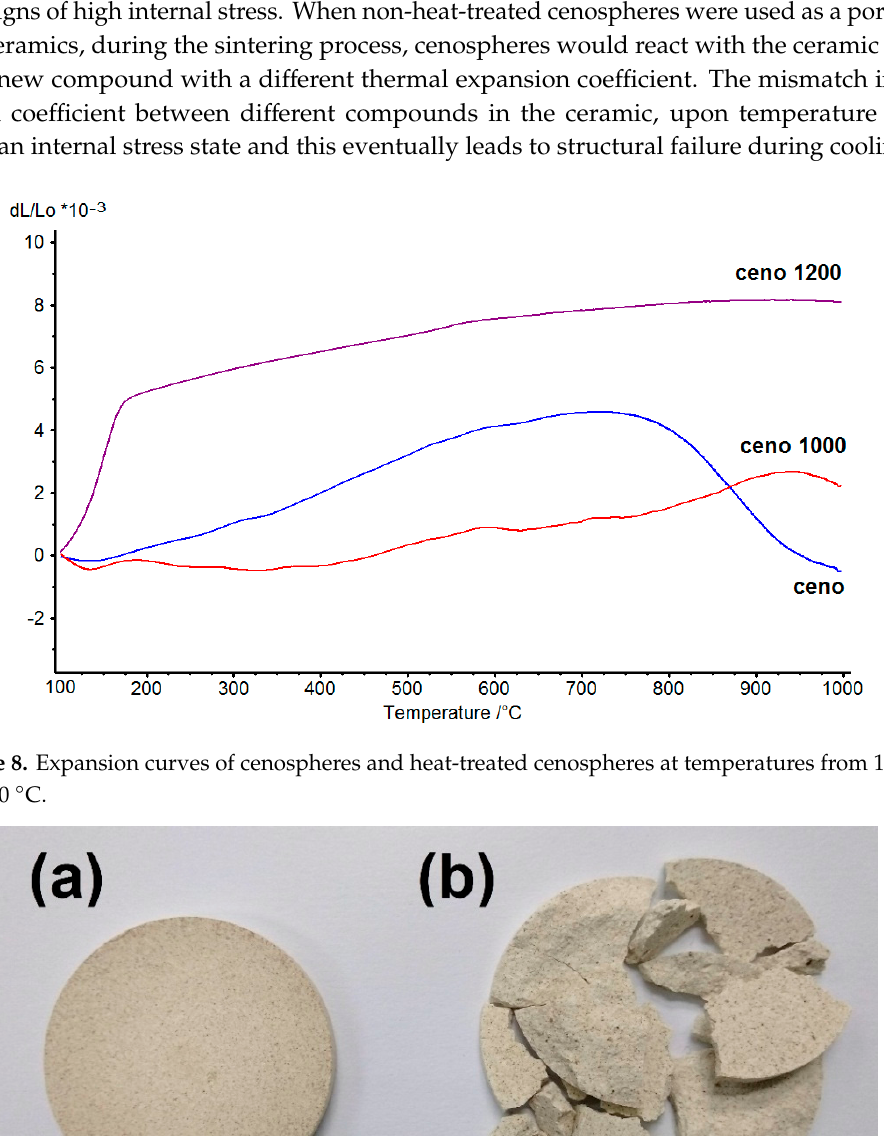
Figure 9. Appearance of two pellets obtained from the sintering mixture of kaolin powder with ( a ) 1100 ◦ C-sintered cenospheres and ( b ) non-heat-treated